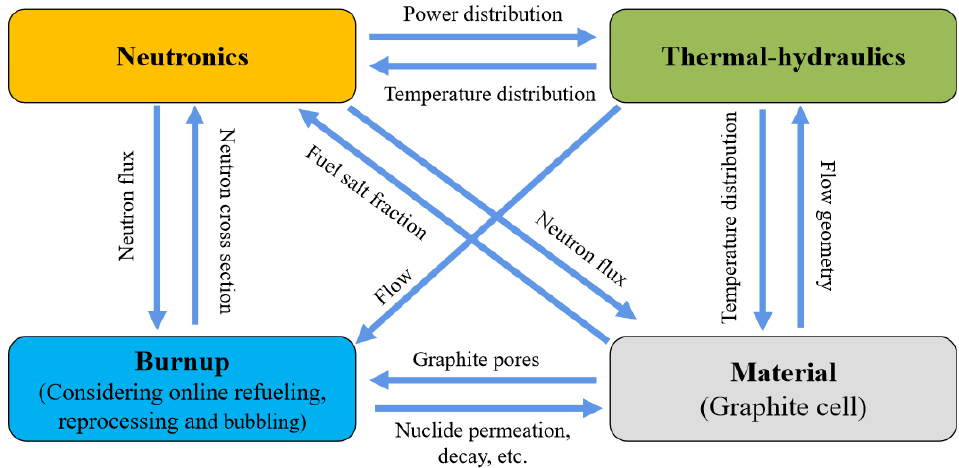
Figure 4. Multi-physics couplings among MSR